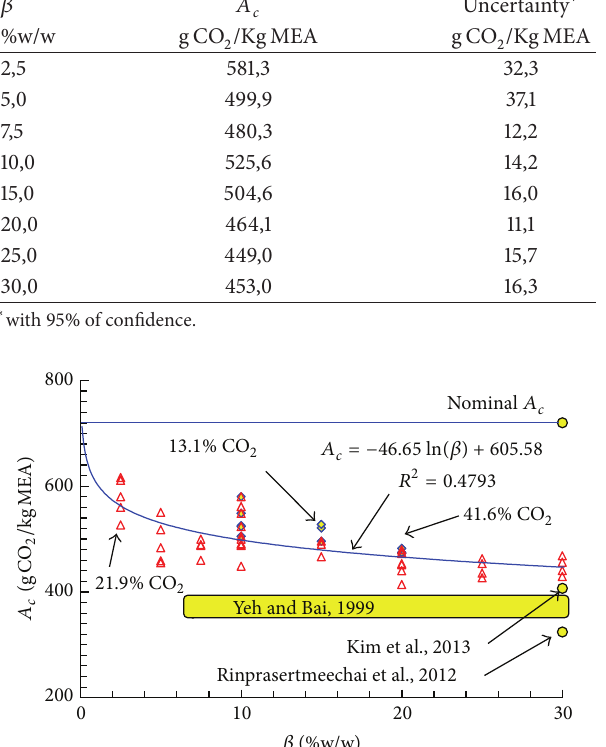
Figure 4: CO 2 absorbing capacity of MEA for several levels of aqueous MEA concentration ( 𝛽 ), obtained using the bubbling method. Yeh and Bai [22] used a reactor with 200 mL of solvent and a gas flow rates of 2–10 SLPM of 8–16% of CO 2 diluted in clean air. Temperature varied from 10 to 40 ∘ C. Rinprasertmeechai et al. [23] used a stirred reactor containing 50 mL of 30% (w/w) aqueous MEA concentration at 25 ∘ C and with a simulated flue gas containing 15% CO 2 , 5% O 2 , and 80% N 2 and flowing at 0.05 SLPM. Kim et al. [24] used a stirred reactor with 1 L of 30% (w/w) aqueous MEA at 25 ∘ C with 30 vol% CO 2 diluted in N 2 and a flow rate of 1 SLPM. All works were conducted at atmospheric